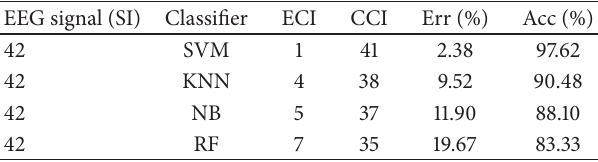
Table 2: The data applied DWT of results in binary